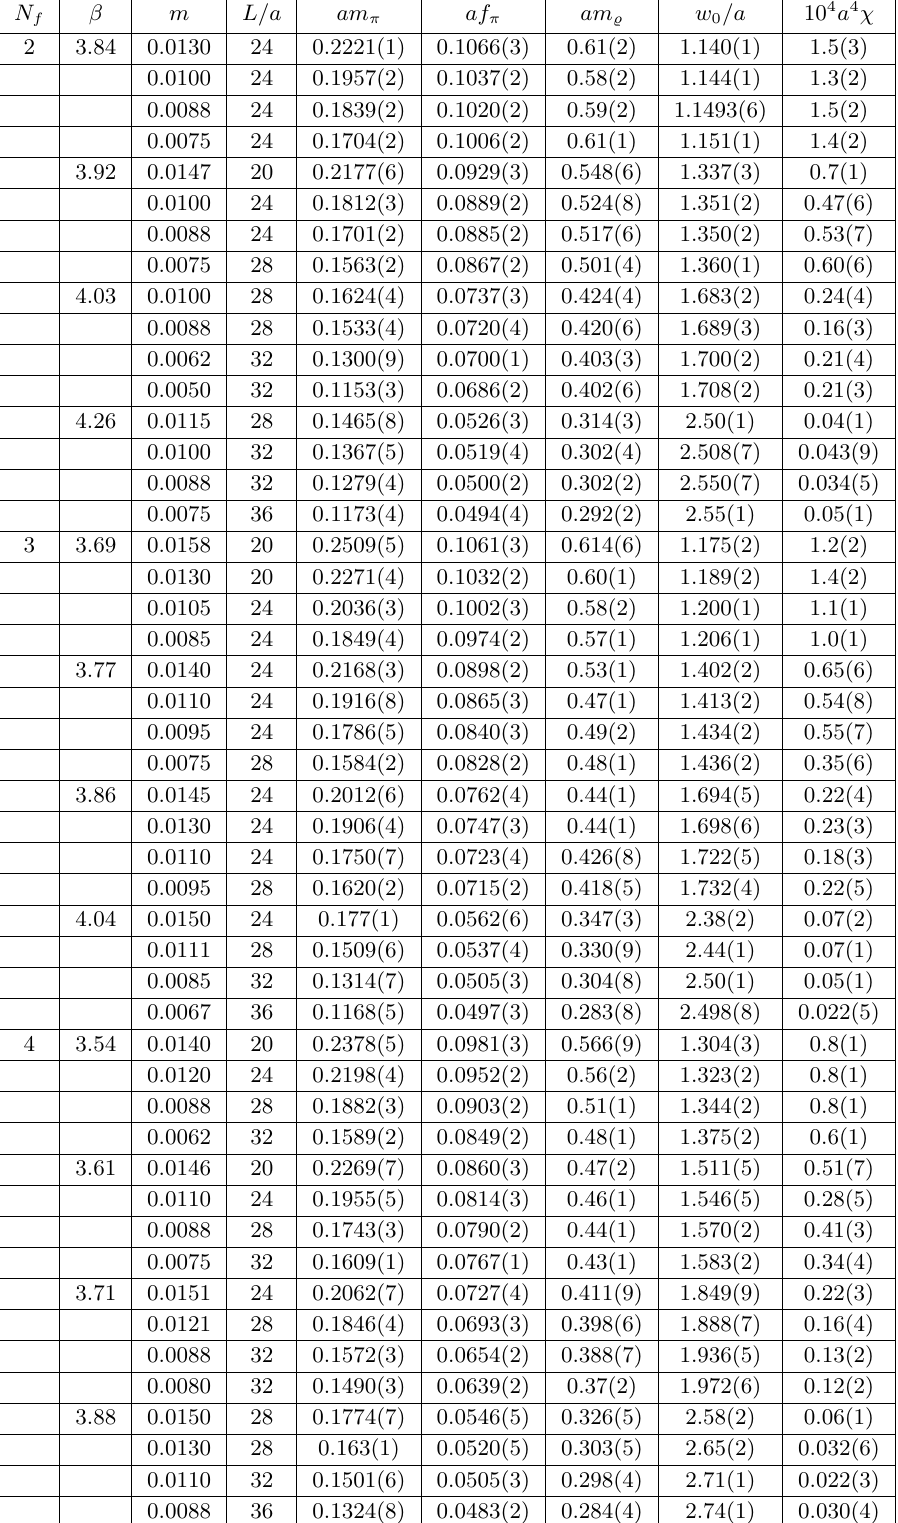
Table 3 . Data for N f = 2 ; 3 ;